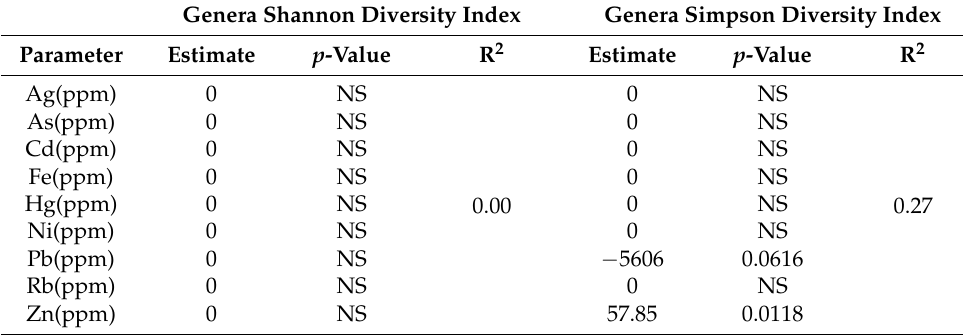
Table A4. Multiple regression model with estimate (slope), combined R 2 , and p -value (significance) of relationship between Shannon and Simpson diversity indices of genera and the metals detected (in ppm) in the sediments of metal